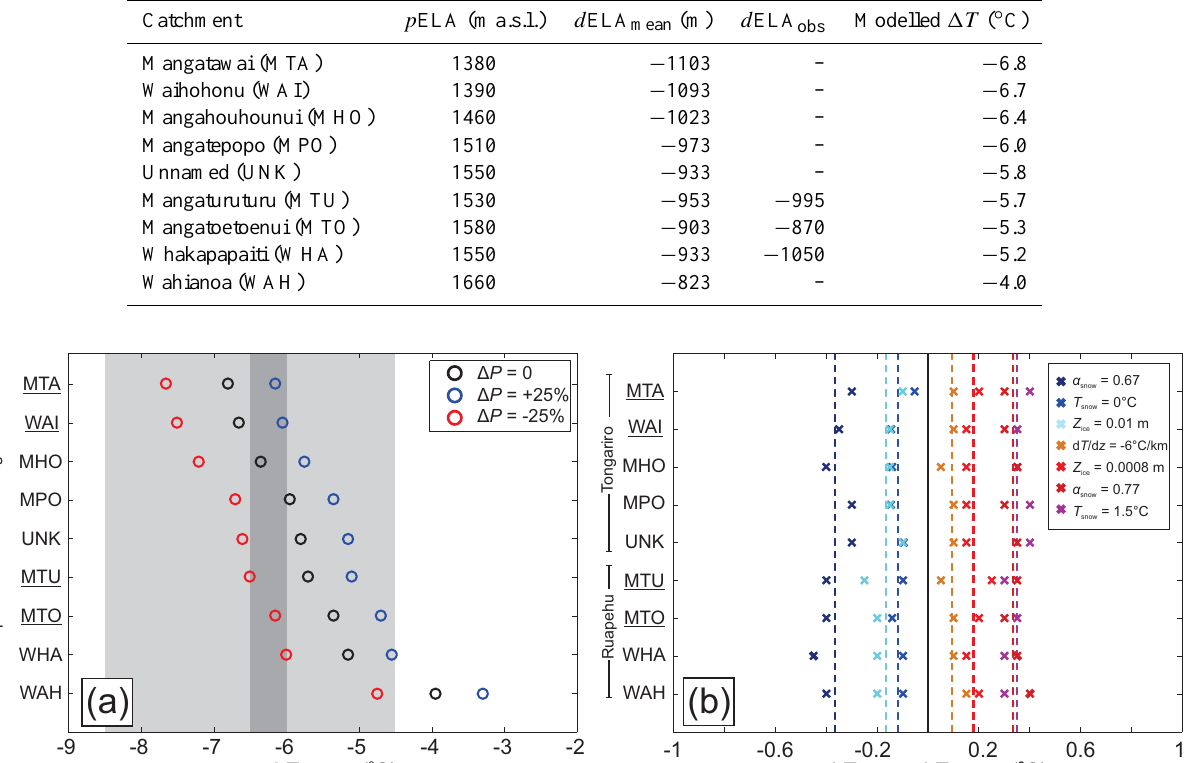
Figure 6. Experiment 2. (a) Temperature forcing, from present, necessary to simulate inferred LGM ice geometries in catchments on Mt Ruapehu and Tongariro massif. Results shown for three precipitation change ( (cid:49)P ) scenarios: 0% (black), + 25% (blue), and − 25% (red) change from present. Underlined labels on the y axis represent catchments where modelled ice thickness spills over ice-marginal landforms, before reaching the geologically inferred terminus (see text). Grey shading depicts the pollen-based southern North Island LGM temperature-lowering estimate of Newnham et al. (2013) (6.5 ± 2.0 ◦ C) – derived using the partial least-squares method and the glacier- model-derived Southern Alps LGM cooling estimate of Golledge et al. (2012) (6.0 to 6.5 ◦ C, when precipitation is reduced by 25%). (b) The sensitivity of palaeotemperature reconstructions for the following parameters: albedo of snow ( α snow ), snow temperature threshold ( T snow ), air temperature lapse rate (d T /d z ), and ice surface roughness ( Z ice ). Dashed lines indicate the mean impact of each sensitivity test. Flow parameters U c and A (not shown) have a negligible ( < 0.1 ◦ C) impact on (cid:49)T